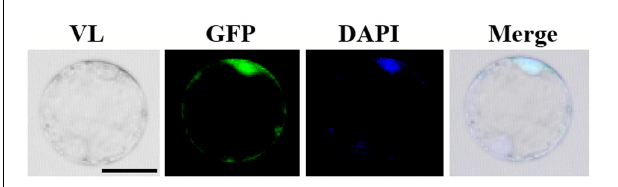
FIGURE 6 | Subcellular localization of OsGIF1. Confocal images of rice protoplast cells after 48 h of infection. The OsGIF1 protein (visualized based on GFP signal) was mainly localized in the nucleus in rice cells transfected with the 2x35S::OsGIF1-GFP construct. Scale bar: 25 µ